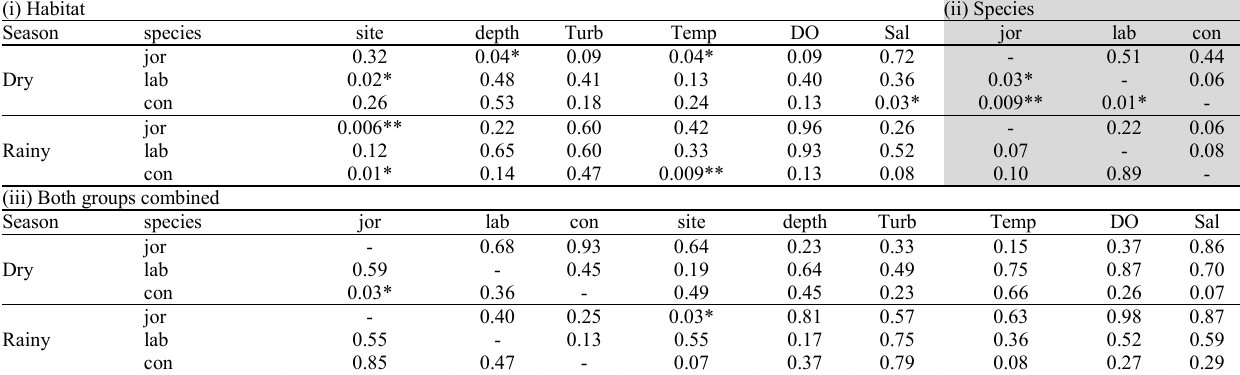
Table 4. Results of General Additive Modeling (GAM) analysis of the effects of (i) the environmental characteristics, (ii) the species abundance and (iii) the combination of the two groups on the zooplanktovorous Chirostoma species at seasonal scale in three years (1999, 2000, and 2001). Abbreviations are: Depth (m), turbidity (NTU; Turb), temperature (°C; Temp), dissolved oxygen (mg•L -1 , DO), salinity (ppt, Sal), Chirostoma jordani (jor), C. labarcae (lab), and C. consocium (con). Shown are the probability values for the full GAM model for each variable. Significant codes: **0.01, *0.05.